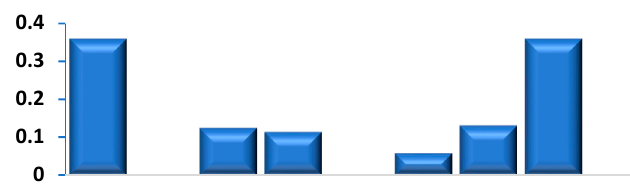
Figure 4. Statistical properties of the evolved MGGP model on the training data ( a ) Gene Weights ( b ) P-Value (low = significant).